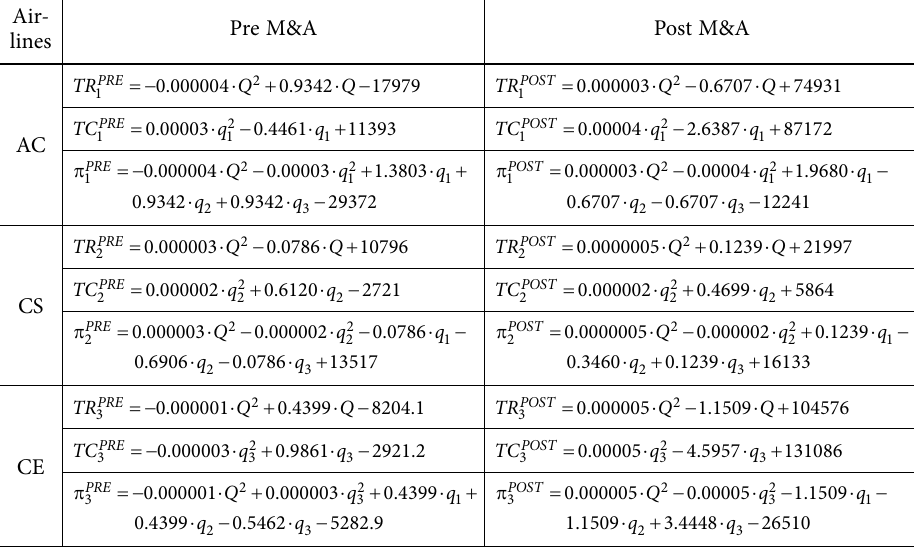
Table 4. Pre and Post M&As revenue, cost, and profit functions for the Big Three Air- lines